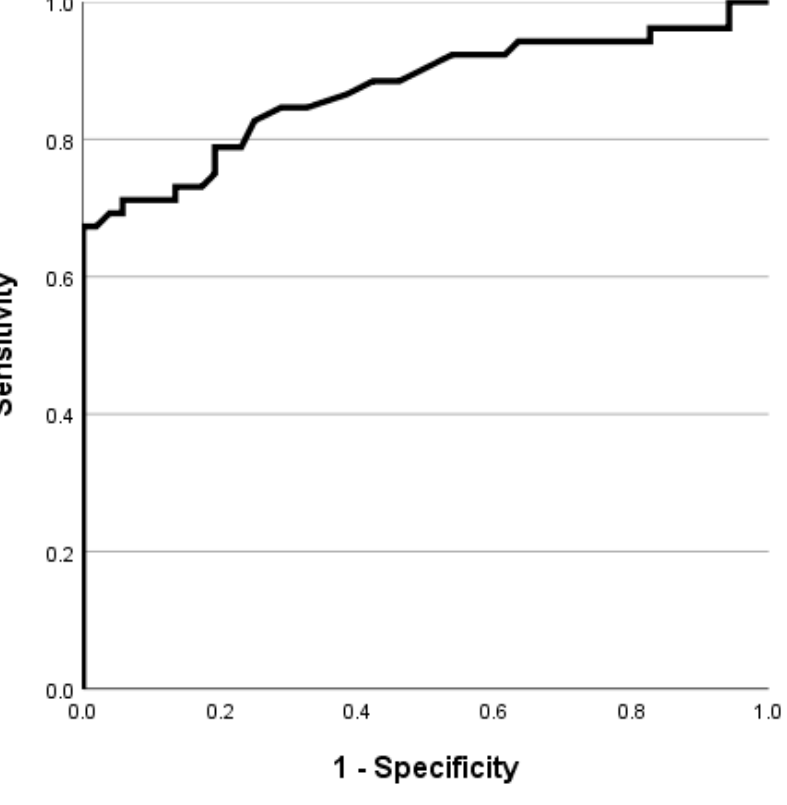
Figure 10. ROC curve of 3D angle.